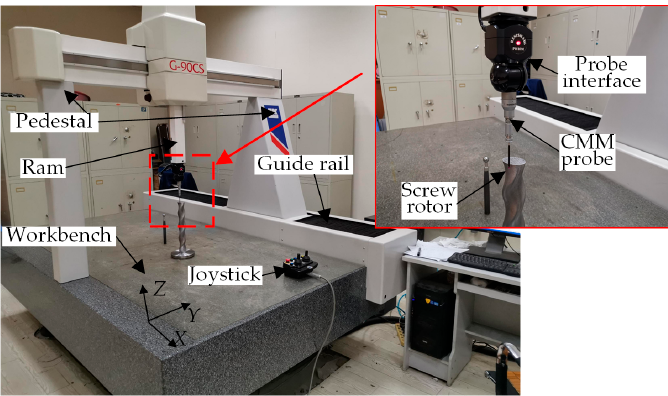
Figure 11. Coordinate measuring machine (CMM) measurement experiment of double-head screw rotor.